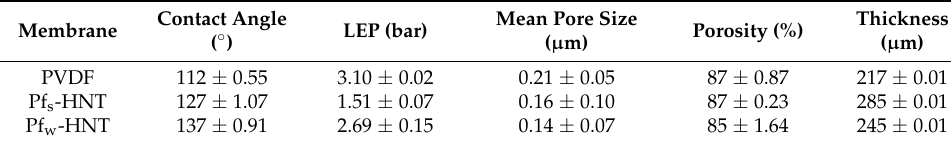
Table 1. Anti-wetting and Pore Properties of the Prepared